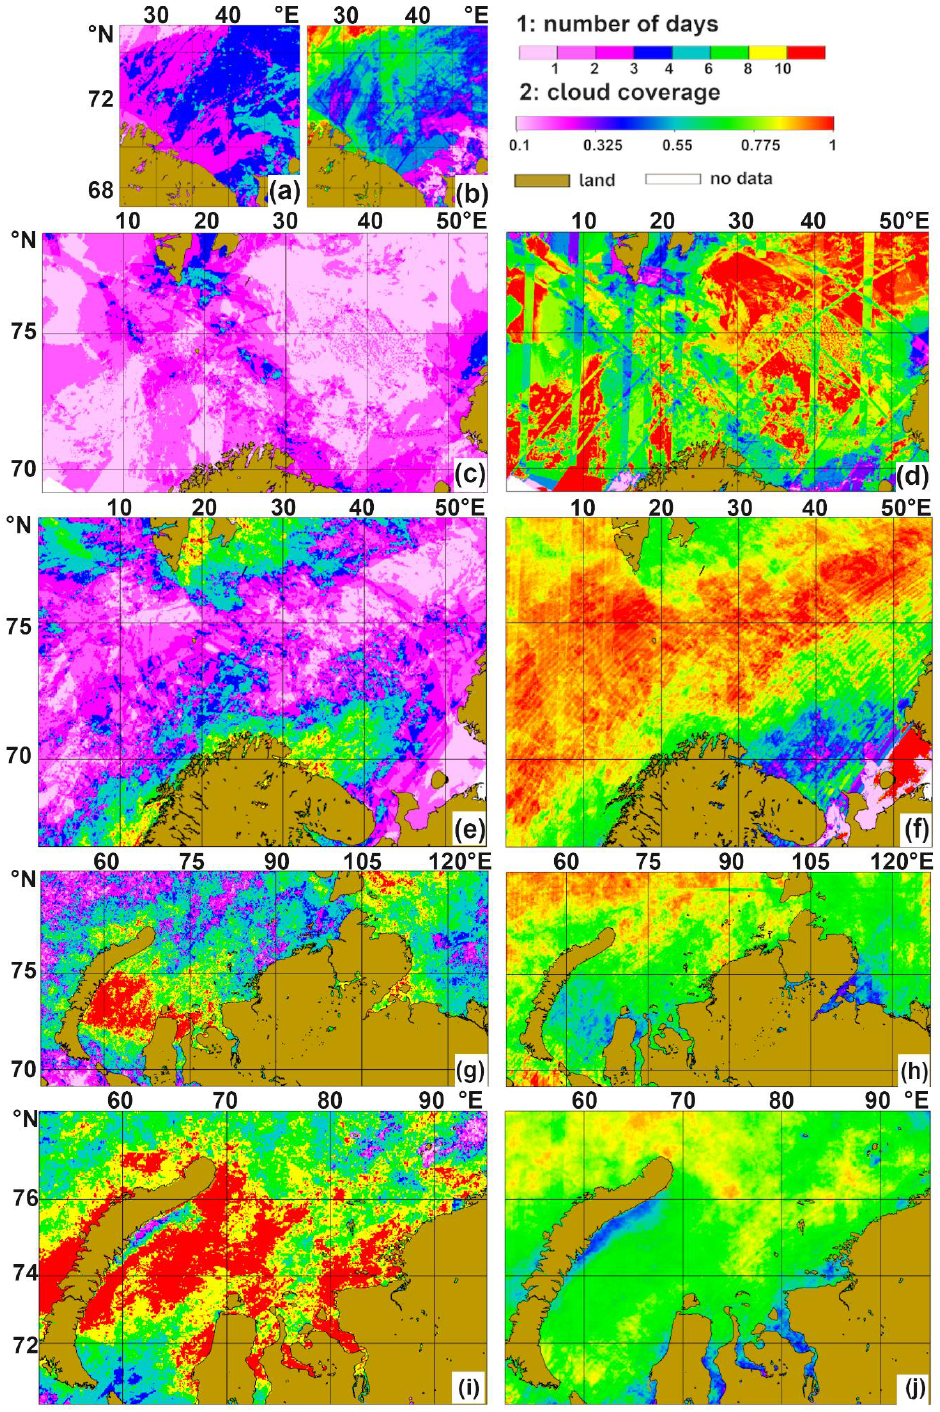
Figure 2. Distributions of the number of days with data per bin ( a , c , e ; scale 1) and cloud coverage according to OLCI_CLOUD flag data ( b , d , f ; scale 2). AMK-65: ( a , b ); AMK-68: ( c , d ); AMK-71: ( e , f ), AMK-72: ( g , h ), AMK-76: ( i , j ).